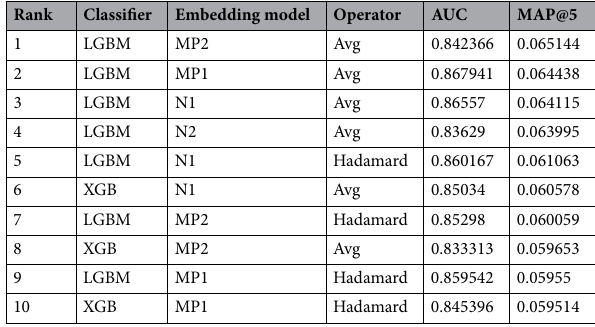
Table 6. Top-10 validation experiment results.